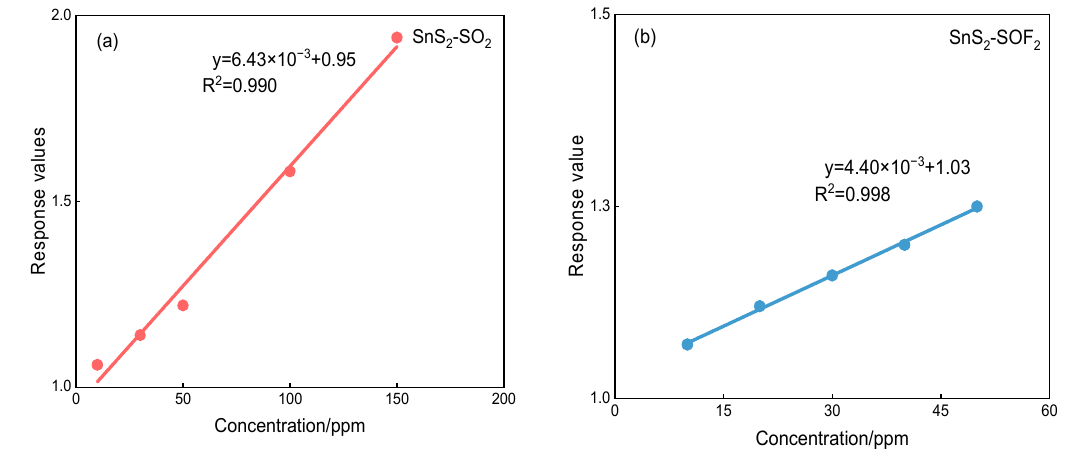
Figure 7. Response–concentration relationship of the sensor to SF 6 decomposition components: ( a ) 150 SO 2; ( b ) 50 SOF 2 .